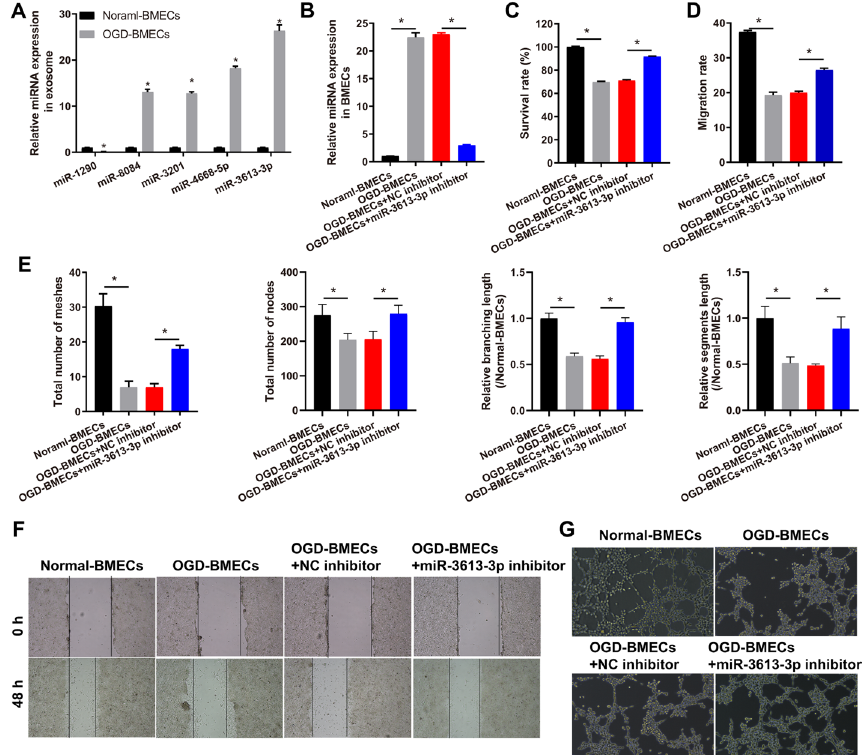
Fig. 1 miR-3613-3p knockdown recovered BMEC proliferation, migration, and angiogenesis in OGD-treated BMECs. A Five miRNAs that prominently changed in the OGD-treated BMEC exosomes based on miRNA GeneChip assay were also confirmed to have prominently changed in the OGD-treated BMEC exosomes on the basis of RT-qPCR. Differences were analyzed using t -test. * P < 0.05. B miR-3613-3p expression in BMECs were measured by qRT-PCR after transfection at 24 h and treated for 4 h. C BMEC proliferation was measured by MTS, and the survival was calculated according to the percentage of the test group/control group (normal-BMECs group). D , E The bar represents the migration rate and angiogenesis (include total number of meshes/nodes and branching/segments length), respectively. F , G Representative image of the migration rate and angiogenesis after transfection at 48 h, followed by OGD treatment for 4 h. Differences were analyzed using ANOVA, followed by post-hoc Dunnett’s multiple comparisons test. * p <